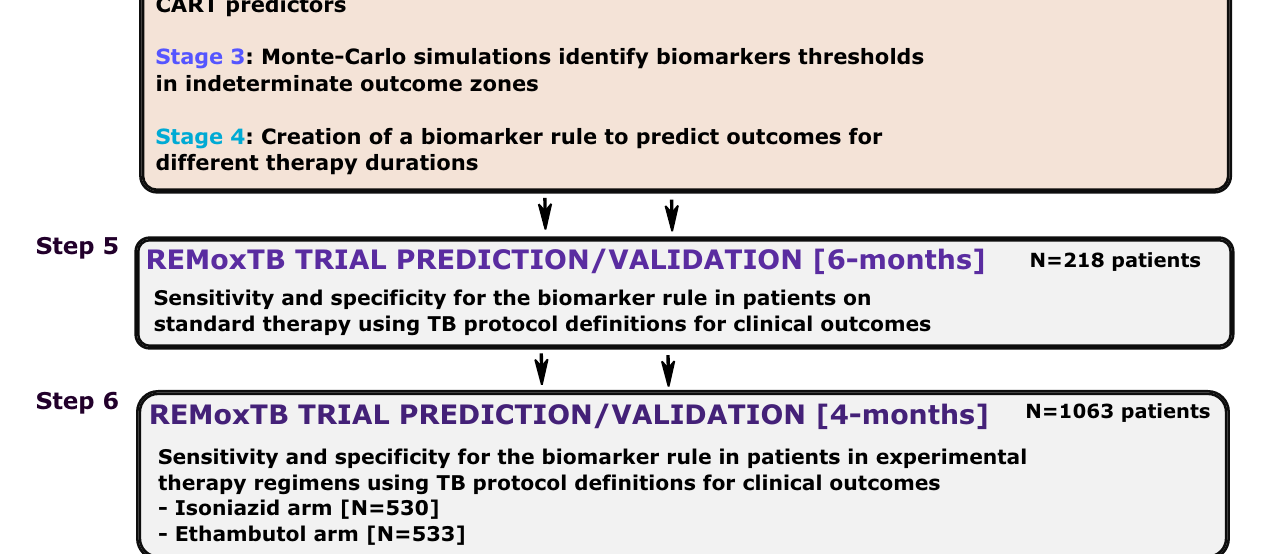
Fig. 1 Biomarker development steps. Step 1 : Patients without suf fi cient data points to derive bacterial kill slopes were removed. Step 2 : The weekly sputum time-to-positivity data was then converted to colony forming units and then modeled using ordinary differential equations. Step 3 : Data partitioning of 50% of patients in standard of care six-months therapy as derivation data-set and the other 50% into valdiation dataset. All patients in experimental arm, administered over 4 months were assigned to validation datasets. Step 4 : Four mathematical modeling and machine learning types of analyses in derivation dataset to 1 identify predictors of time-to-extinction (TTE) and 2 threshold values deliniating different TTE, and 3 design a diagnostic rule for different therapy durations. Step 5 : Accuracy of diganostic rule/biomarker for six-months therapy duration in standard of care validation dataset using clinical de fi nitions of outcome (relapse, cure). Step 6 : Accuracy of diganostic rule/biomarker for four-months therapy duration in two experimental arms in validation dataset using clinical de fi nitions of relapse and